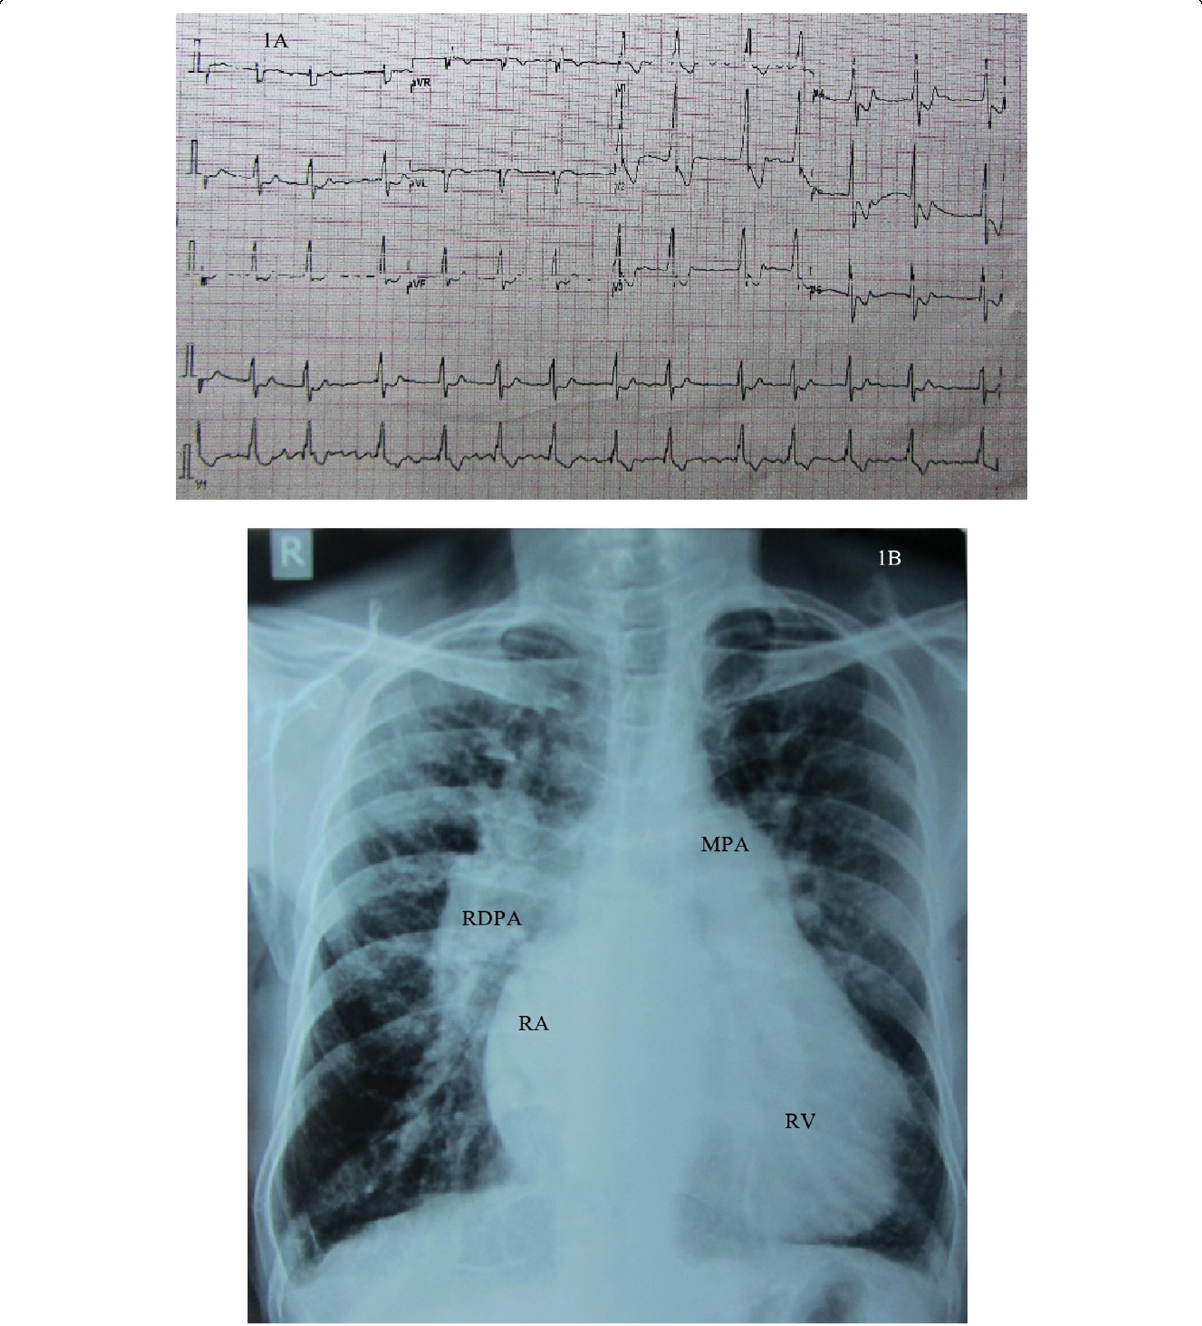
Fig. 1 Twelve lead surface electrocardiogram showing right bundle branch block with atrial fibrillation ( A ) and chest X-ray posteroanterior view showing situs solitus, levocardia, right atrial enlargement, right ventricular apex, dilated main and right descending pulmonary arteries, and peripheral pruning of pulmonary vessels ( B ). RA, right atrium; RDPA, right descending pulmonary artery; MPA, main pulmonary artery; RV, right